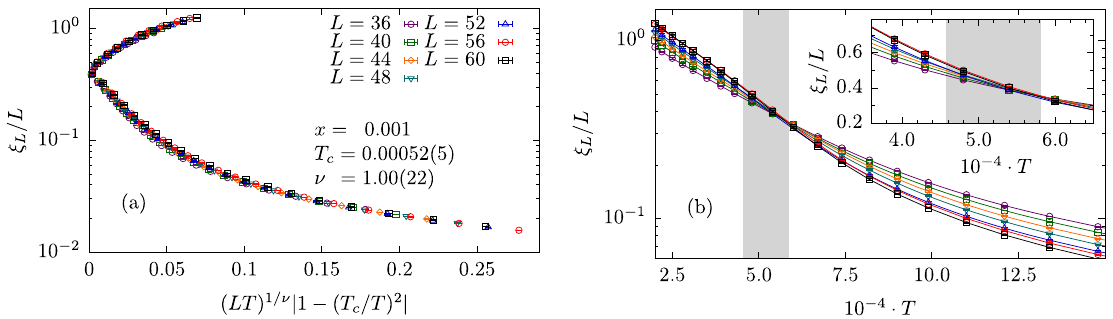
FIG. 1. (a) Example finite-size scaling data collapse of the spin-glass two-point finite-size correlation function ξ L =L using an extended scaling form [39] for the extreme dilution x ¼ 0 . 001 . The optimal scaling is accomplished via a Levenberg-Marquardt minimization procedure described in Ref. [40]. (b) Unscaled two-point finite-size correlation function divided by the linear system size ξ =L for the extreme dilution x ¼ 0 . 001 and system sizes L ¼ 36 ; … ; 60 . Data for different system sizes cross at the critical temperature T c . The vertical shaded area represents the estimated critical temperature T c ¼ 0 . 00052 ð 5 Þ K; its width is the statistical uncertainty determined via an extended finite-size scaling [panel (a)]. The inset zooms into the critical temperature region showing that the data do indeed